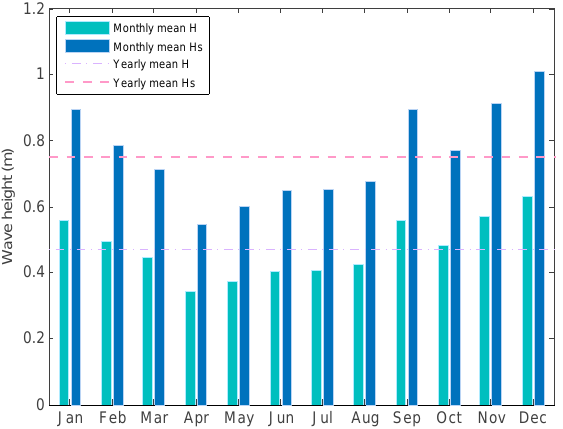
Figure 3. Annual variation of the significant wave height H S at the Lysekil test site in the years